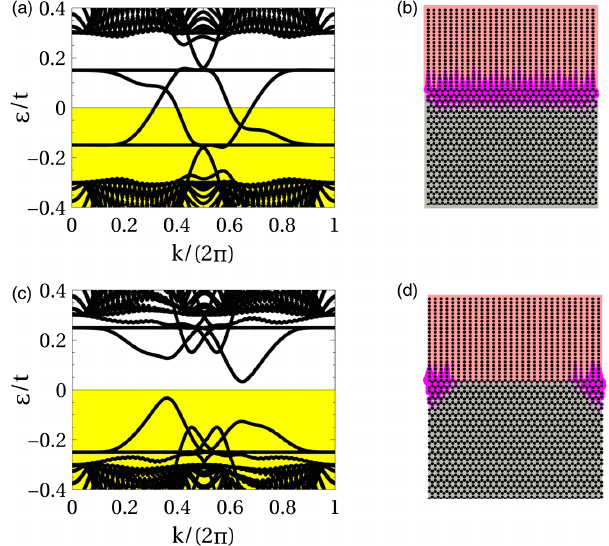
FIG. 8. Band structure of the interface between a square superconductor and an antiferromagnet (a) or canted antiferro- magnet (c) honeycomb lattice. Panels (b) and (d) show the local density of states in a finite system, which correspond to gapless interface channels (without canting) (b) and Majorana states (with canting)